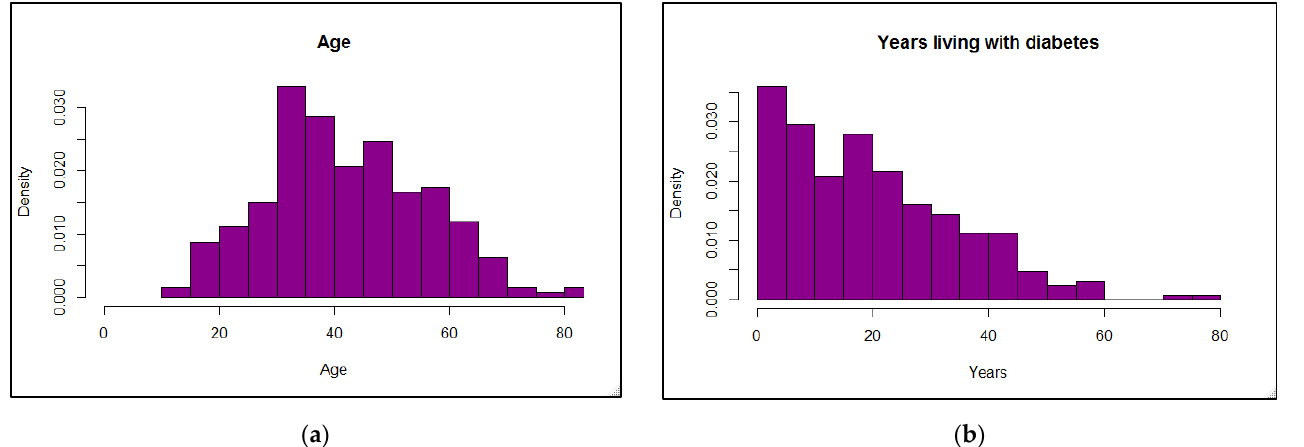
Figure 1. Distribution of participants by age ( a ) and years living with type 1 diabetes ( b